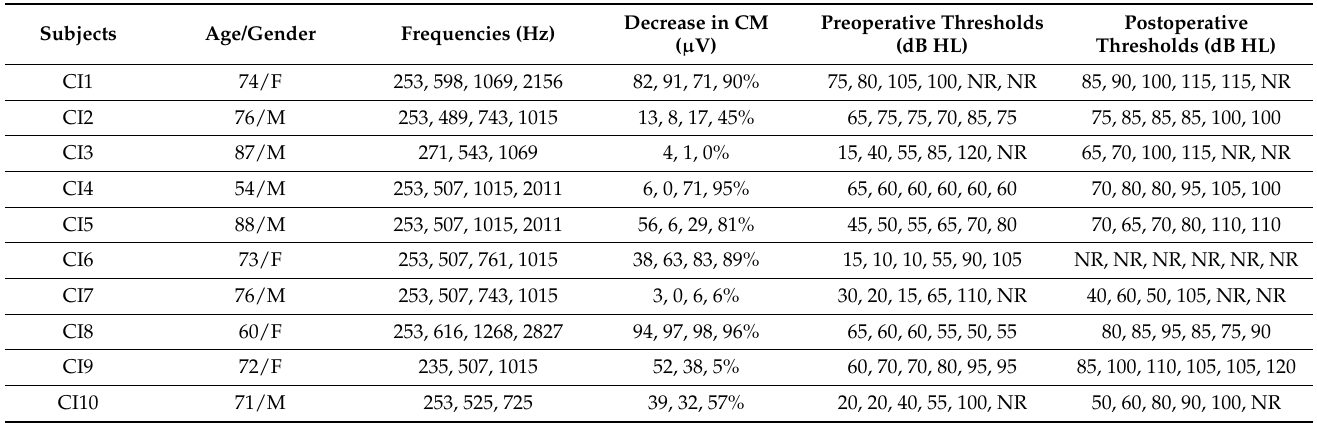
Table 1. Subject demographics, hearing thresholds and electrocochleography details.